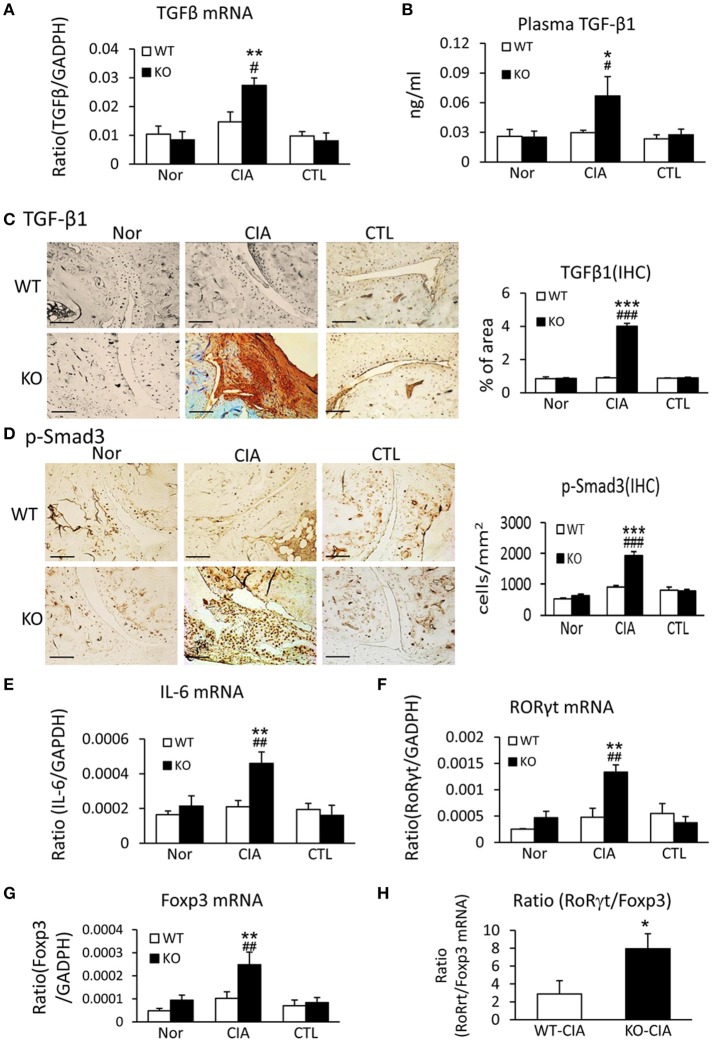
Deletion of Smad7 enhances TGF-β1/Smad3 and IL-6 signaling and promotes Th17 over the Treg responsein the synovial tissues of CIA in CD-1 mice. (A) Synovial TGF-β1 mRNA expression by real-time PCR. (B) Plasmalevels of TGF-β1 by ELISA. (C) Synovial IL-6 mRNA expression by real-time PCR. (D) Synovial RORγt mRNA expression by real-time PCR. (E) Synovial TGF-β1 expression by immunohistochemistry. (F) Activation of Smad3 signaling identified by phospho-Smad3 (p-Smad3) nuclear translocation. (G) Synovial Foxp3 mRNA expression by real-time PCR. (H) Ratio of synovial RORγt/Foxp3 mRNA expression. Data are expressed as mean ± S.E. for group of 8 mice. *p < 0.05, **p < 0.01, ***p < 0.001 vs. control (CTL); #p < 0.05, ##p < 0.01, ###p < 0.001 vs. WT-CIA group. Scale bar, 50 μm.